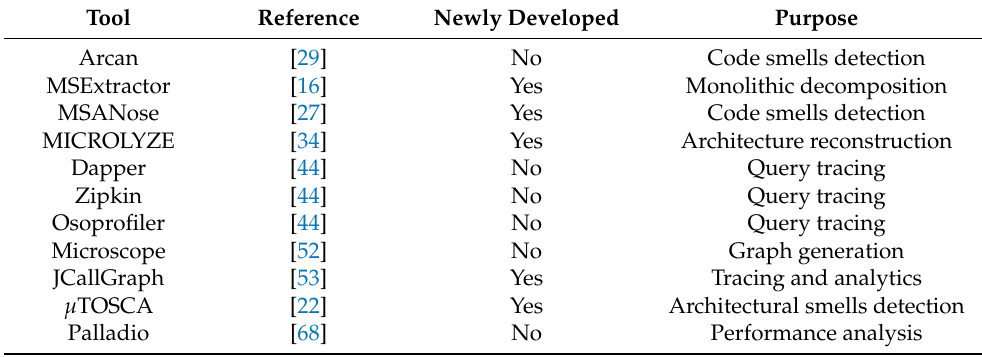
Table 4. Identified